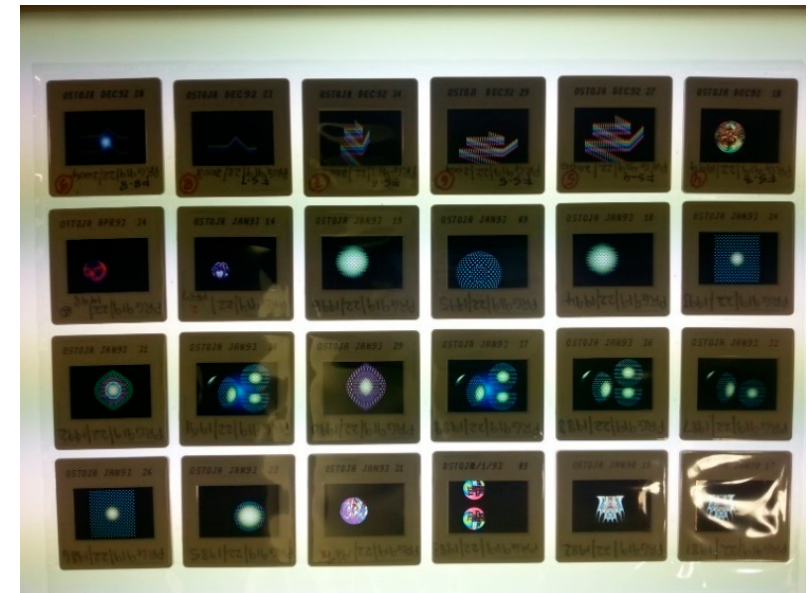
Figure 25. One of Ostoja’s landscapes with CGI, featuring Mandelbrot imagery mapped onto a sphere. The landscape is the very recognisable Uluru. Published with permission. Image courtesy of the State Library of South Australia., PRG919/21/163.